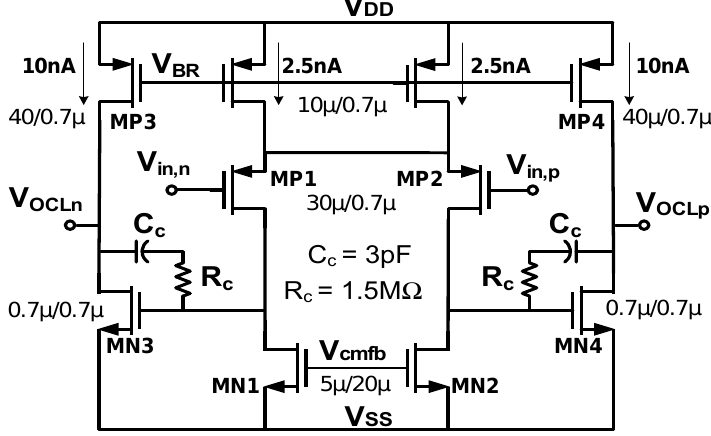
Figure 6. Schematic of the folded cascode op amp using buck control with its noise sources. Table 1. Dimension of MOSFETs in a folded cascode op amp.